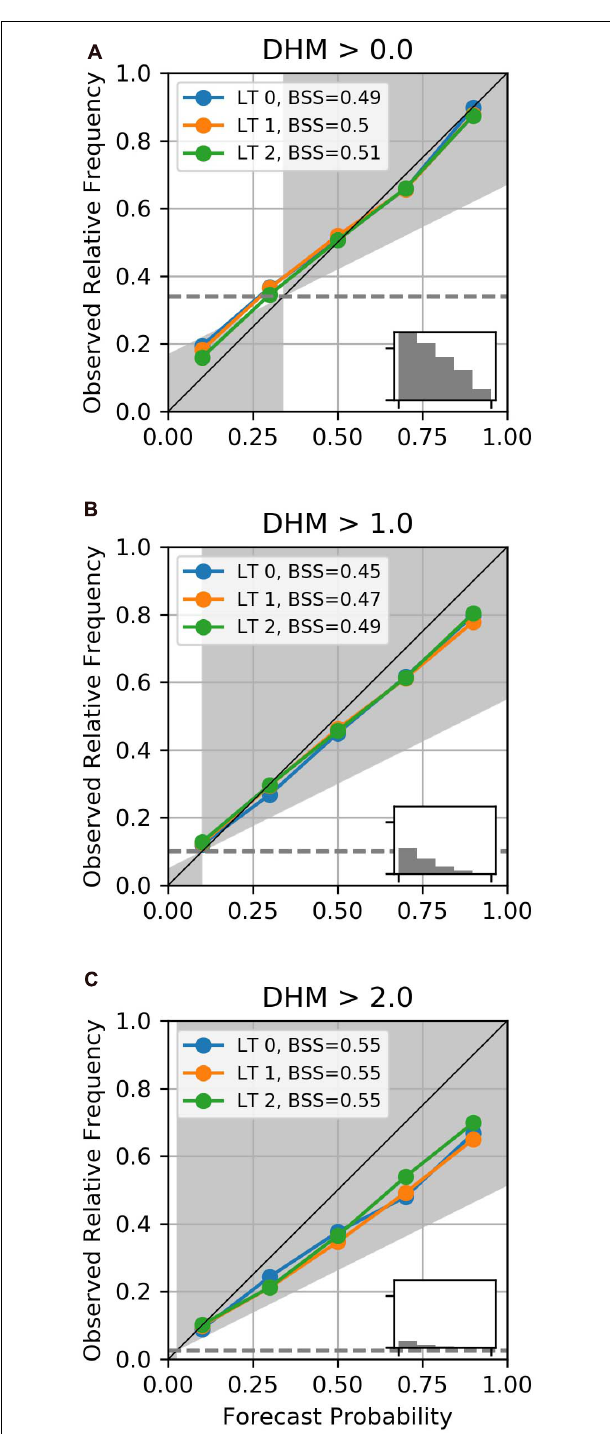
FIGURE 6 | Reliability diagram for (A) DHM > 0, (B) DHM > 1, and (C) DHM > 2 for November to April 1990–2012 for lead times 0–2 months, using a 22 member ensemble. Domain is the whole of northern Australia as shown Figure 1 . Brier Skill Scores (BSS) and bar charts showing observed occurrences for each 0.2 frequency bin are also included. Reference forecast used is DHM quasi-persistence for the same period (see section “Materials and Methods” for